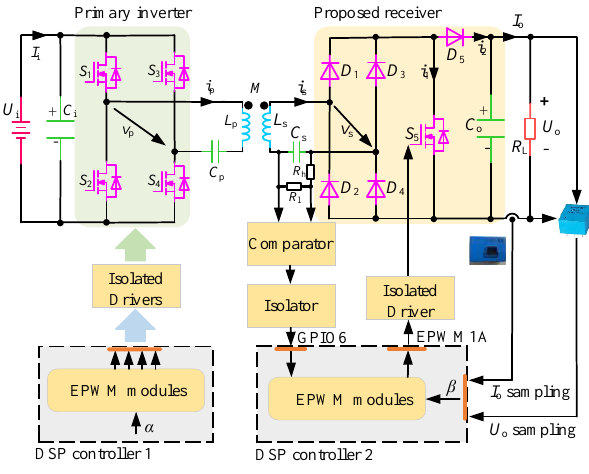
Figure 4. Schematic of DPC system.